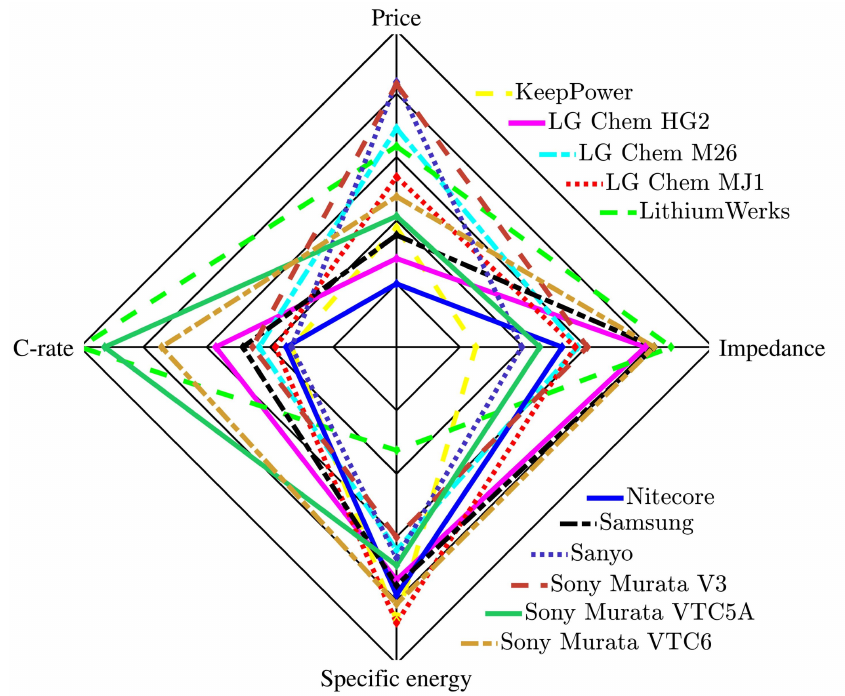
Figure 11. Radar chart: multiple-criteria evaluation of the selected state-of-the-art battery